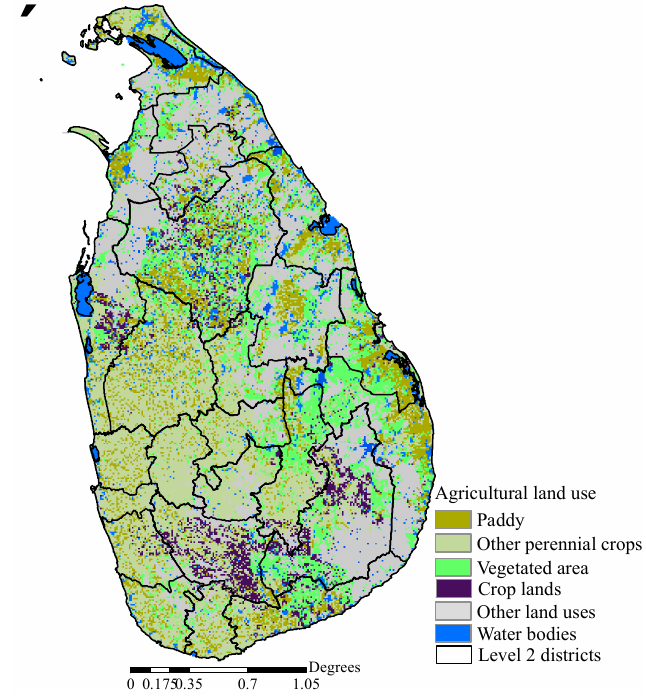
Figure 2. The spatial distribution of the agricultural land use in Sri Lanka. Table 2. Area coverage of the land use classes shown in Figure 2.